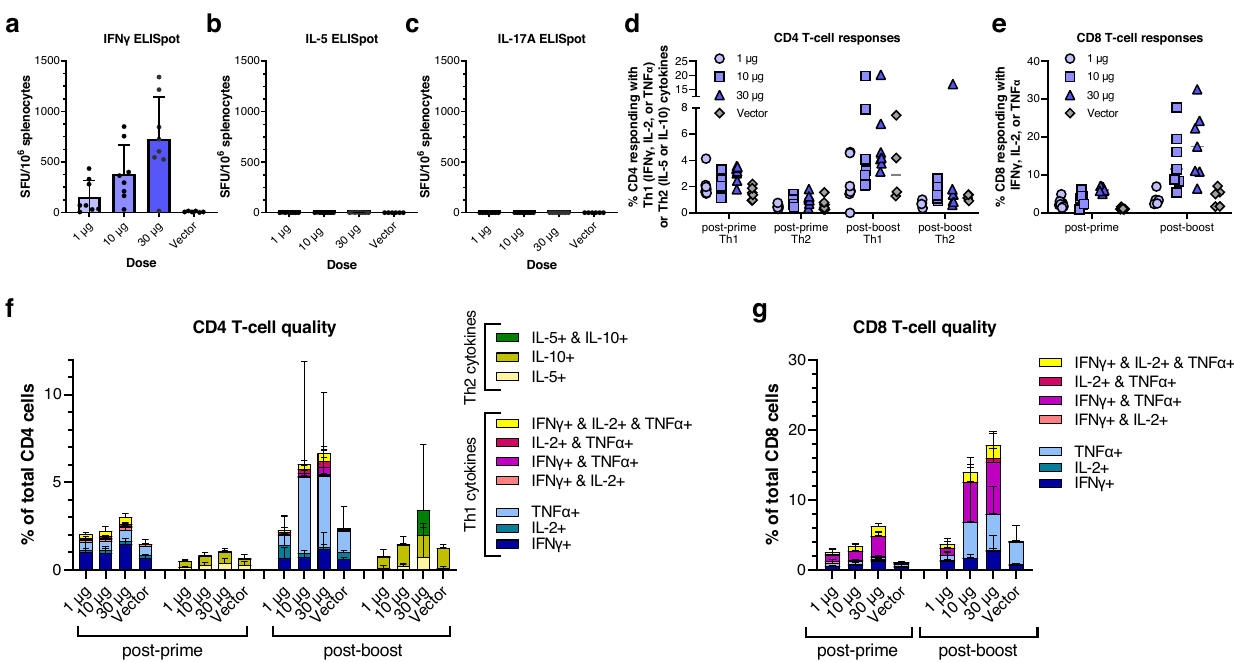
Fig. 5 Detailed cellular immunogenicity pro fi les of optimized SARS-CoV-2 D614G-2P-3Q saRNA/NLC vaccine (AAHI-SC2) after prime or prime-boost immunization of C57BL/6 J mice. a SARS-CoV-2 spike-reactive spleen-resident IFN γ + T cells by ELISpot. SFU = spot forming units. Results show mean and standard deviation (SD). b SARS-CoV-2 spike-reactive spleen-resident IL-5 + T cells by ELISpot. Results shows mean and SD. c SARS-CoV-2 spike-reactive spleen-resident IL-17-A + T cells by ELISpot. Results shows mean and SD. CD4 ( d ) and CD8 ( e ) T cells responding with any Th1 (IFN γ , IL-2, or TNF α ) or Th2 (IL-5 or IL-10) cytokines post-prime and post-boost were plotted representing the total number of responding cells, for CD4 or CD8 cells per mouse. Horizontal lines show median. f , g Quality of responding CD4 and CD8 T cells. Total Th1 or Th2 responses were subdivided by cells responding with one, two, or three cytokine(s) to show magnitude and quality of Th1 and Th2 responses, with bar graphs showing the average percentage across each group of mice. The vector control represents mice injected with 10 μ g of NLC-complexed saRNA expressing the non-immunogenic secreted embryonic alkaline phosphatase (SEAP) gene. Results show mean and SD. n = 6 mice for SEAP control group and n = 8 for dosing